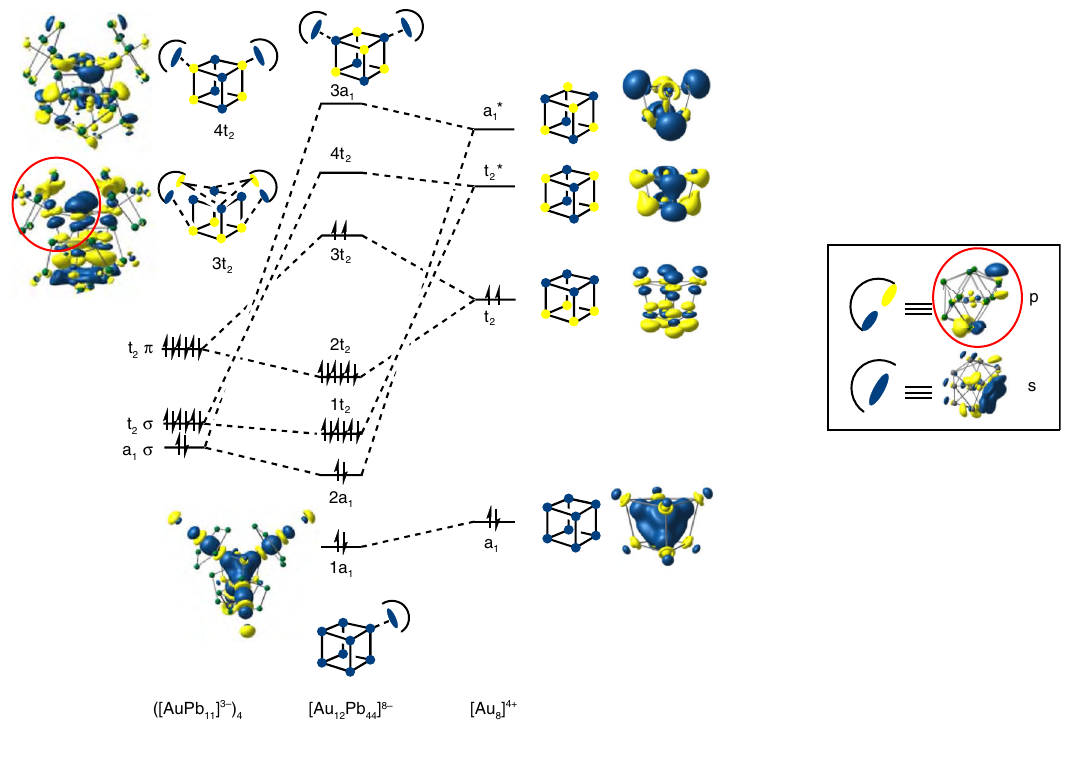
Fig. 7 Electronic structure of [Au 12 Pb 44 ] 8 − . Schematic MO diagrams for [Au 12 Pb 44 ] 8 − , with orbitals labeled according to T d point symmetry. The majority of the Pb atoms have been removed from the iso-surface plots for clarity. Cartoon depictions of the orbitals are provided to guide the